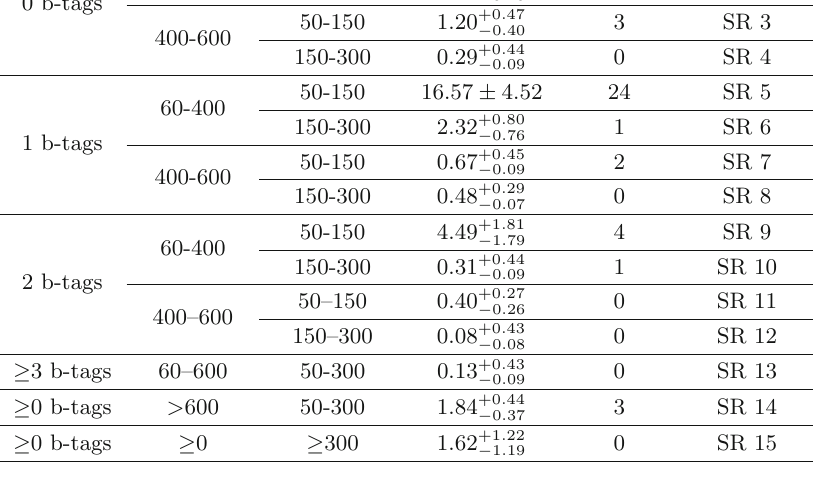
Comparison of observed event yields in data with predicted background yields